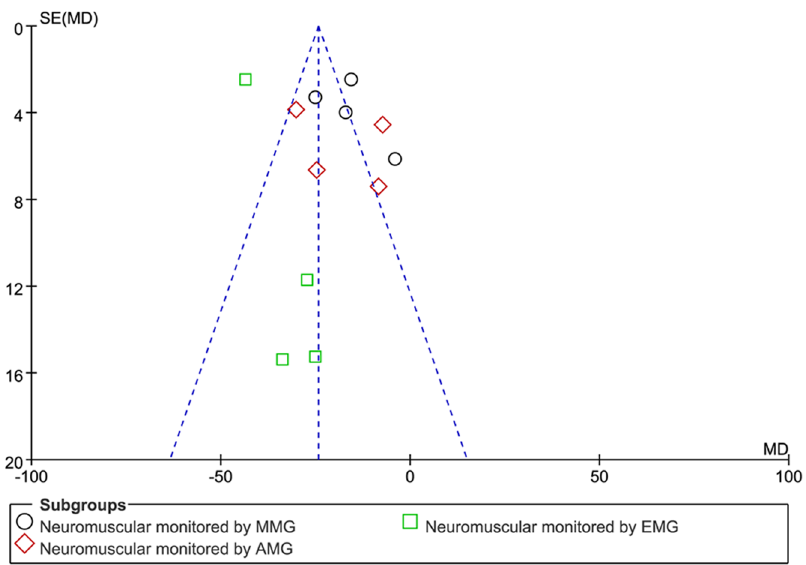
Figure 3. Funnel plot of studies based on rocuronium priming. AMG: acceleromyography; MMG: mechanomyography; EMG: electromyography; Administration protocol of rocuronium priming: 0.06 mg/kg rocuronium was first intravenously administrated as priming dose, then 0.54 mg/kg rocuronium i.v.